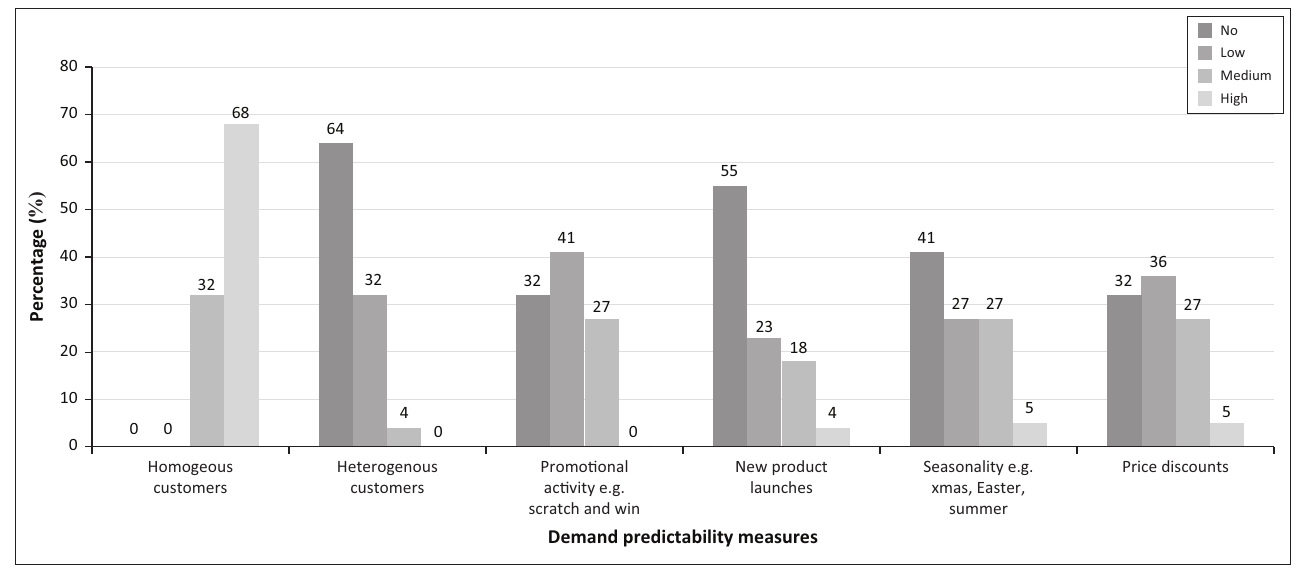
FIGURE 3: Customer demand predictability (respondents’ rating in %